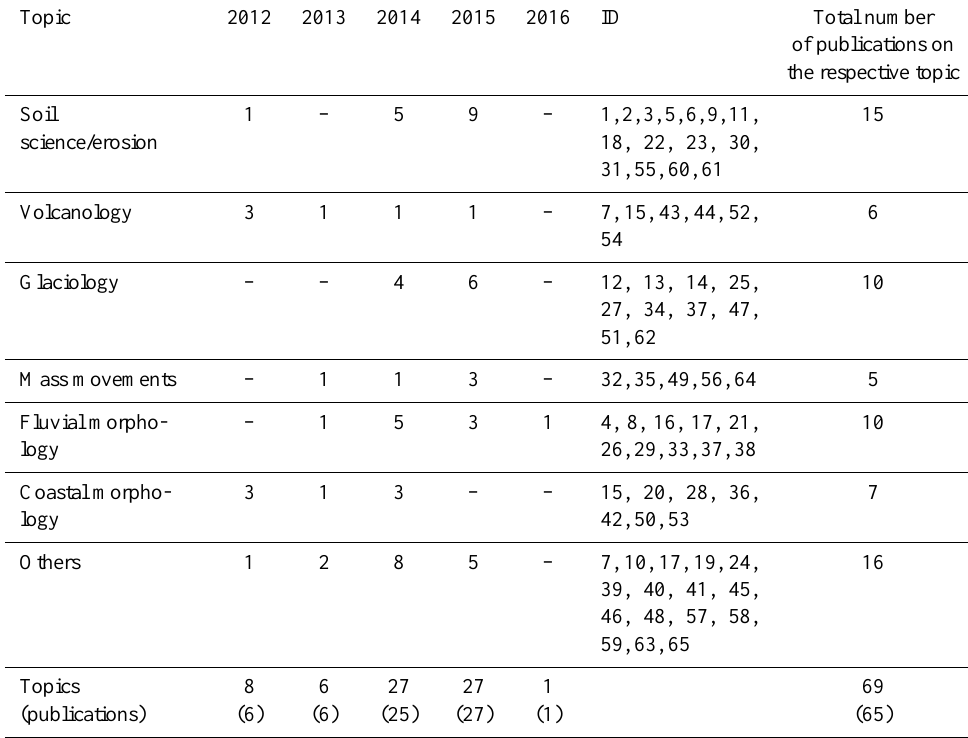
Table 4. Overview of the publication history divided into the main topics from 2012 until editorial deadline in November 2015. Several publications examined more than one topic, resulting in a larger number of topics than actual publications (number in brackets in last row). IDs refer to the table in Appendix